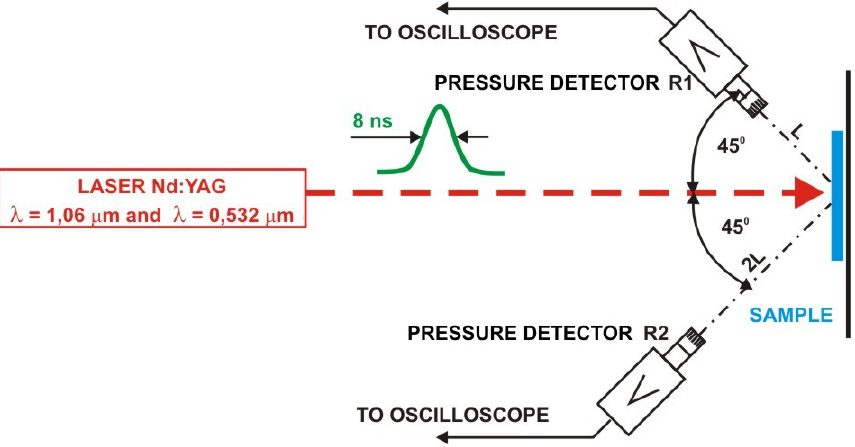
Figure 41. Experimental arrangement for acoustic assessment of the shockwave amplitude accompanying pulse laser